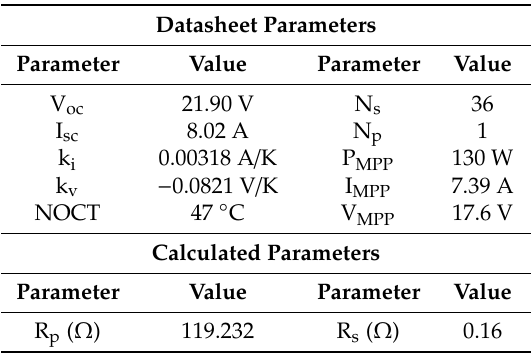
Figure 5. Schematic of System 2. Table 3. KC130GHT-2 PV module